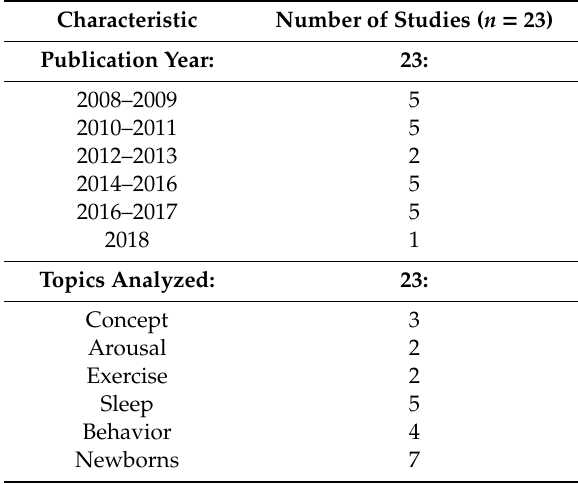
Table 1. General summary of the characteristics of the experimental studies analyzed.